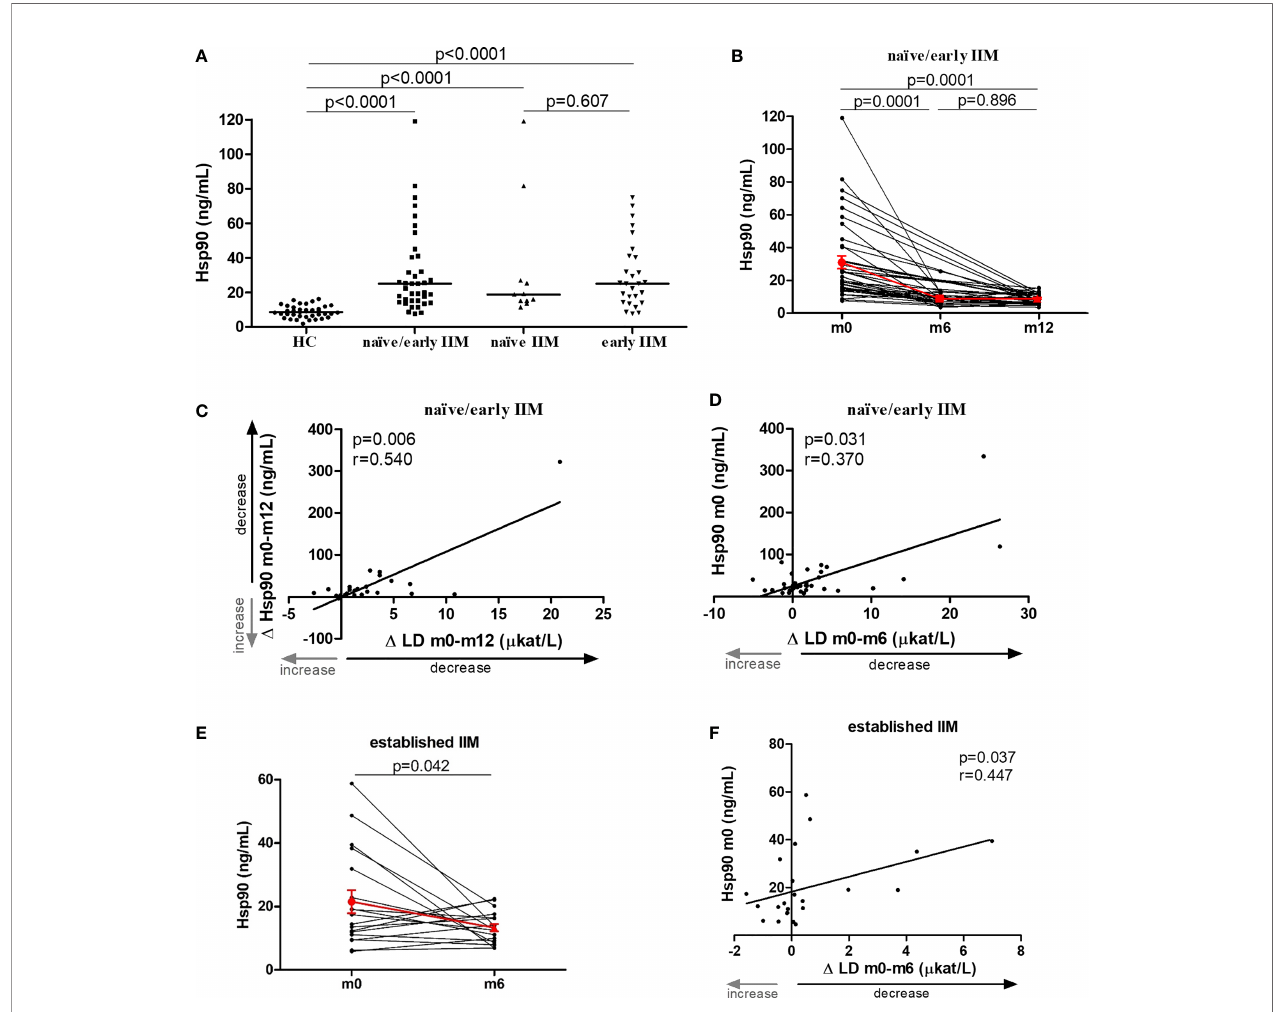
FIGURE 2 | The effect of pharmacotherapy on plasma Hsp90 levels in patients with IIM. (A) Plasma Hsp90 levels were increased in both treatment naïve patients with idiopathic in fl ammatory myopathies (naïve IIM) and patients with short disease duration with recently started pharmacological treatment (early IIM) compared to healthy controls (HC). Horizontal bars represent the median. (B) Upon 6 and 12 months of standard-of-care pharmacotherapy, plasma Hsp90 levels signi fi cantly decreased in treatment naïve/early IIM patients. (C) The 12-month change in Hsp90 was associated with the 12-month change in LD levels. (D) Baseline Hsp90 predicted the 6-month change in LD levels. (E) In IIM patients with established disease, ongoing standard-of-care pharmacotherapy resulted in a signi fi cant decrease in plasma Hsp90 levels over six months. (F) Baseline Hsp90 levels were able to predict the 6-month change in the levels of LD. The red line and whiskers represent the mean and standard error of the mean (B, E)